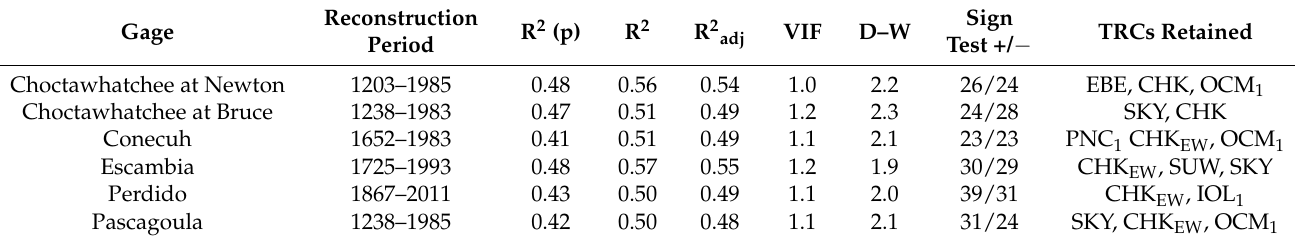
Table 3. March–October streamflow reconstruction statistics and standard tree-ring chronologies (TRCs) used in each model.